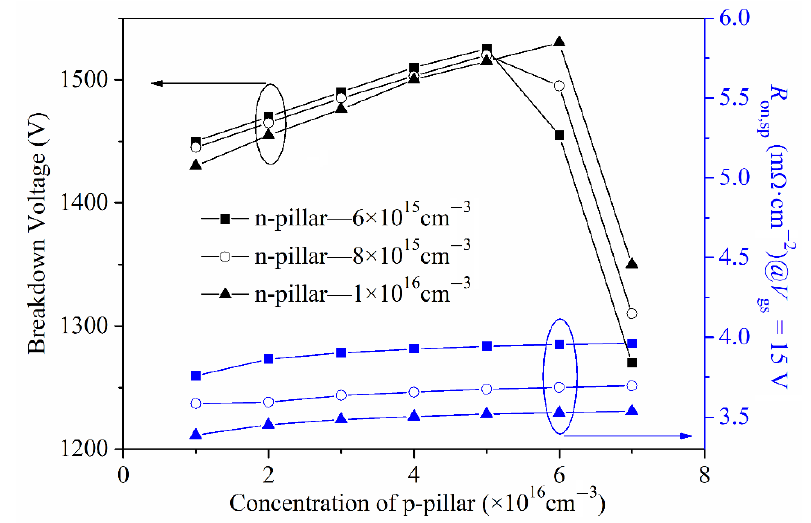
Figure 12. Effect of concentration of the p-pillar and n-pillar on the BV and R on,sp.